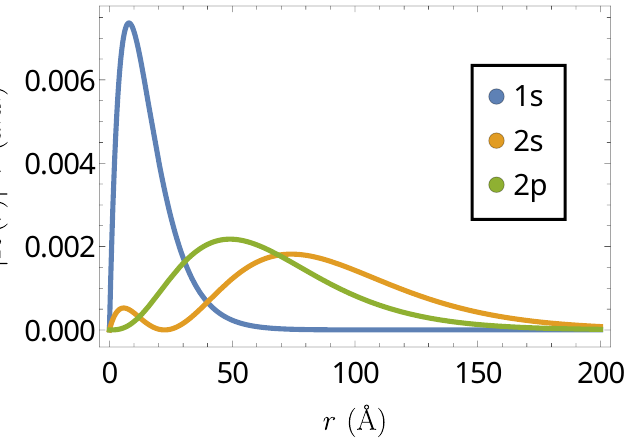
Figure 2. Radial probability density for the 1 s (blue), 2 s (orange), and 2 p (green) states as described by the variational wave functions of Equations (14) and (23) in a hBN monolayer encapsulated in fused